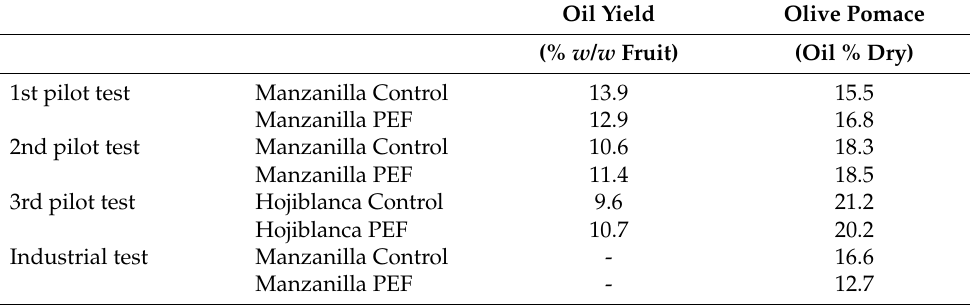
Table 2. Oil extraction yields and oil contents of pomaces obtained from ‘Manzanilla’ and ‘Hojiblanca’ olive fruits extracted with a standard protocol (Control) and by applying pulsed electric field (PEF) technology. Oil Yield Olive Pomace (% w / w Fruit) (Oil % Dry) 1st pilot